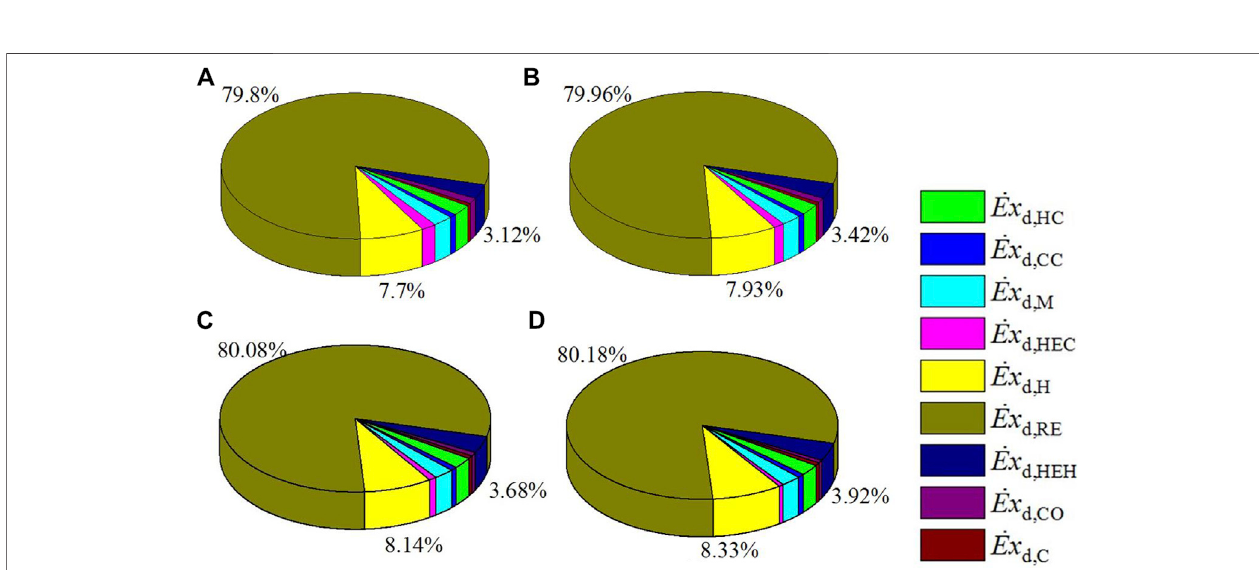
FIGURE 9 | Distribution proportion of exergy destruction for each component under different space velocities, (A) 2800h − 1 , (B) 3200h − 1 , (C) 3600 h − 1 , (D) 4000h − 1 .